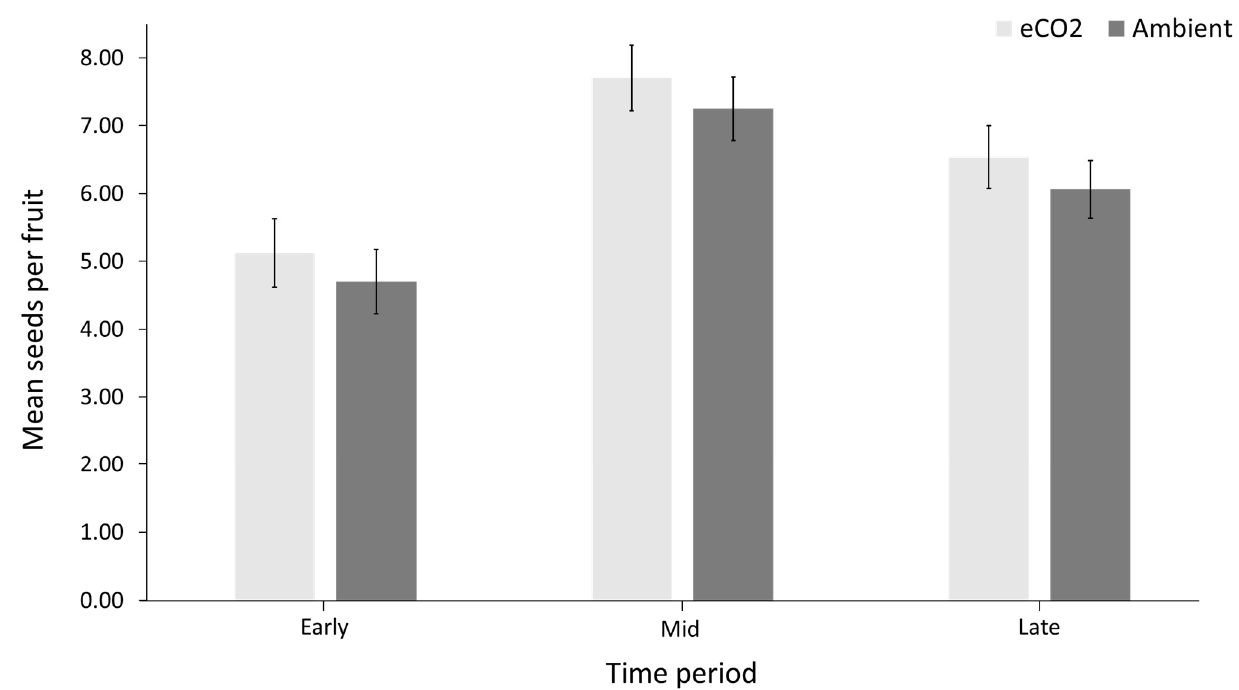
Figure 4. Mean seeds per fruit for eCO 2 vs. ambient for each time period during flowering. n = 60 fruits per patch (total 360) at each time point. Error bars denote ± standard error of the mean.